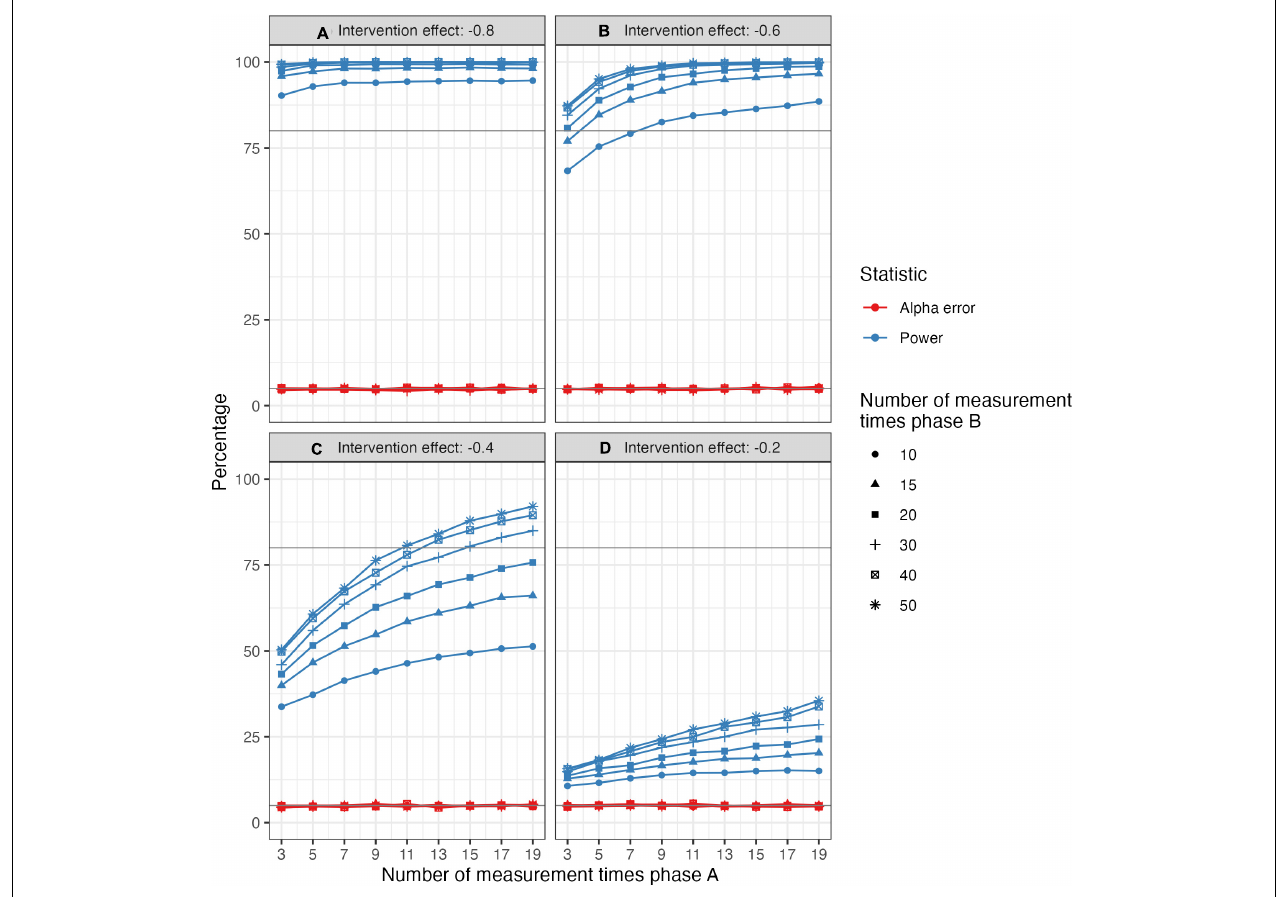
FIGURE 3 | Power and alpha error rates (line colour) for different intervention effect sizes (part) and measurement times per phase (dot shape and x -axis) (simulation